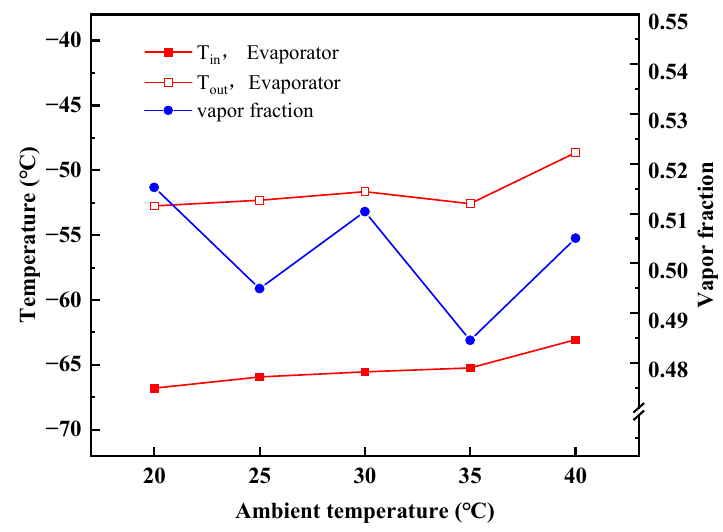
Figure 11. Parameters on the evaporator at different ambient